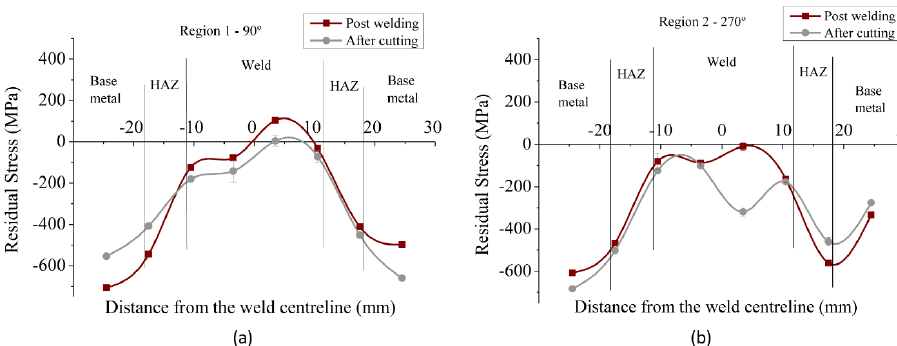
Figure 4. Influence the cutting process in the residual stresses profile of the sample 1: (a) region 1-90°; (b) region 2-270°.